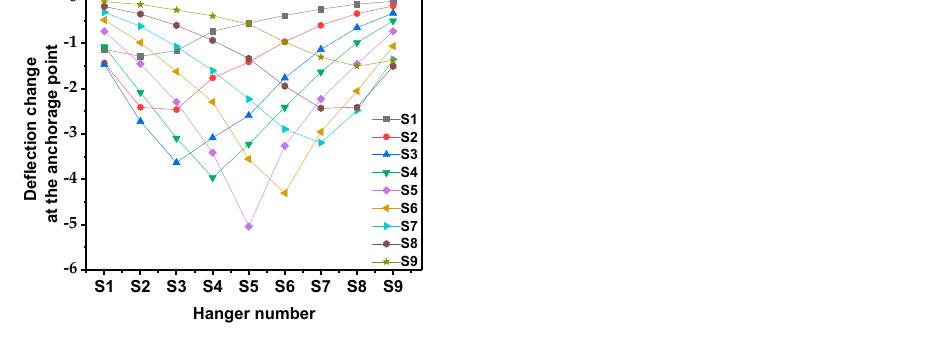
Figure 12. Deflection difference at each anchorage point when the hanger on the south side of the model bridge is wholly damaged.